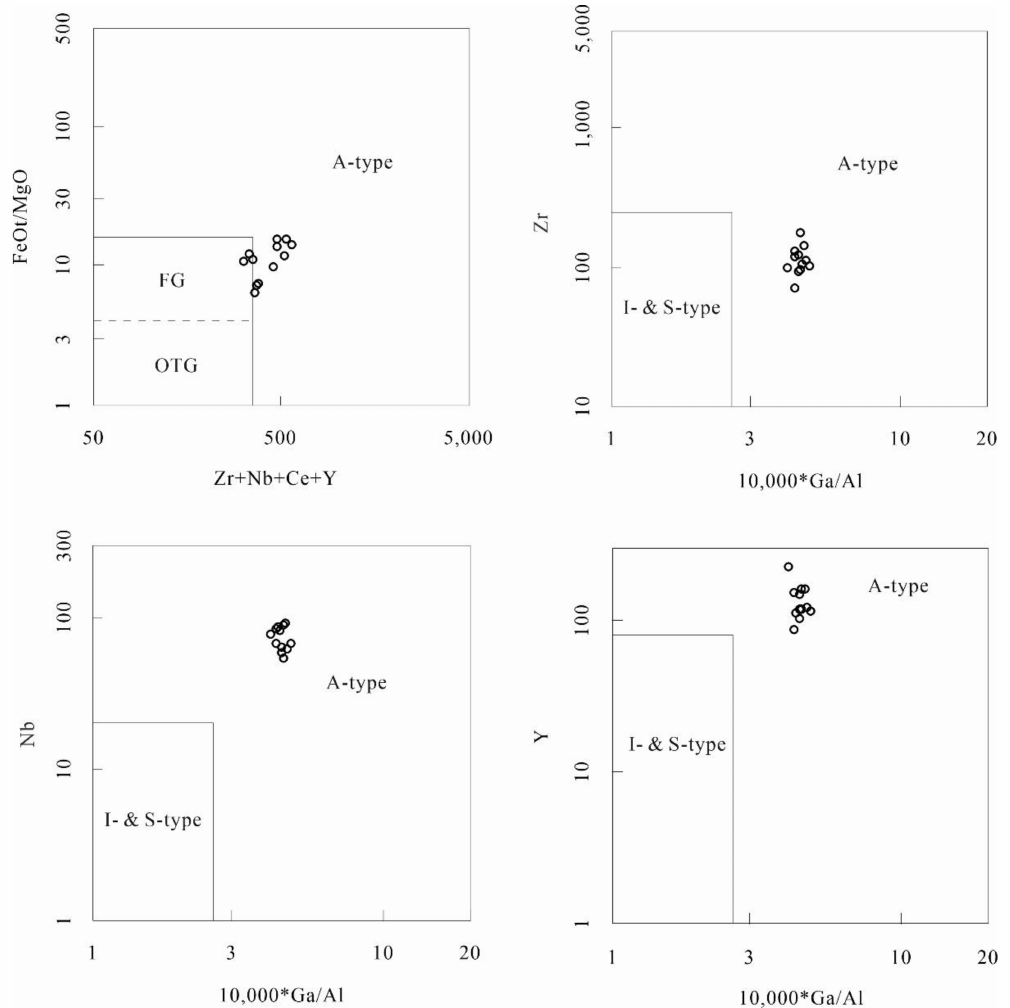
Figure 9. Discrimination diagrams to distinguish A-type granitoids. FG—fractionated felsic granites; OGT—unfractionated M-, I- and S-type